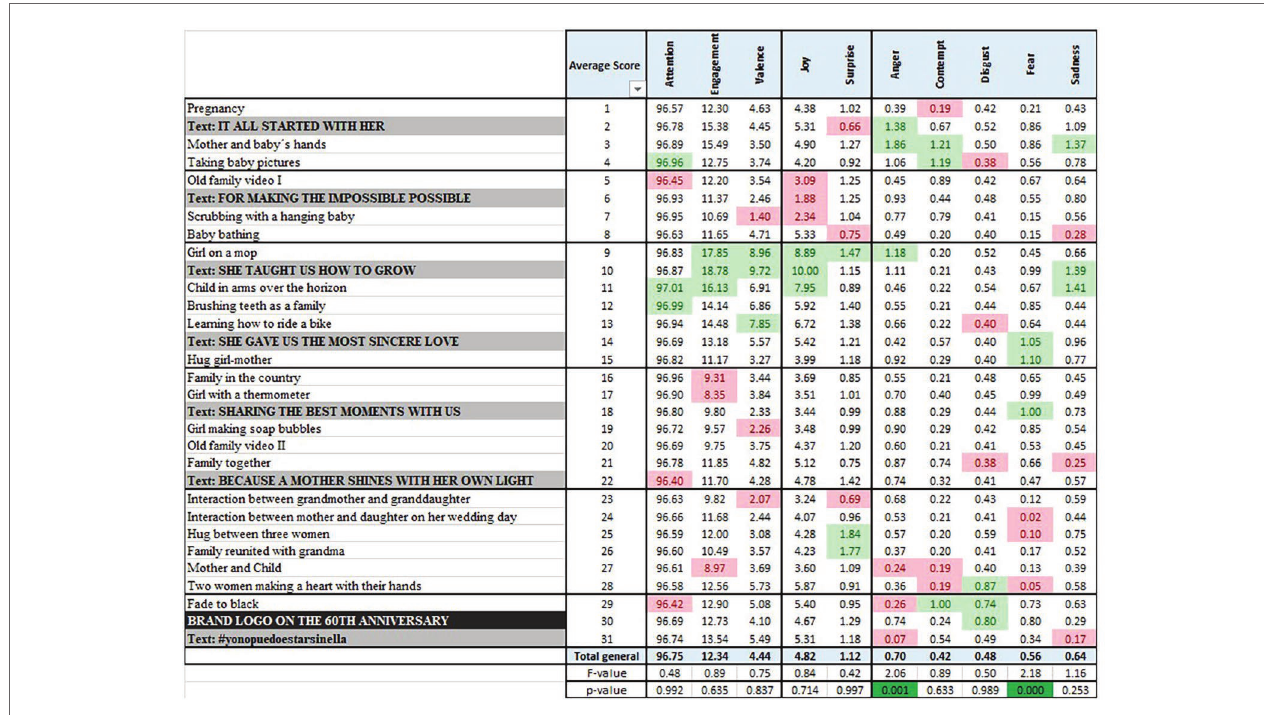
FIGURE 3 | Inferential analysis per